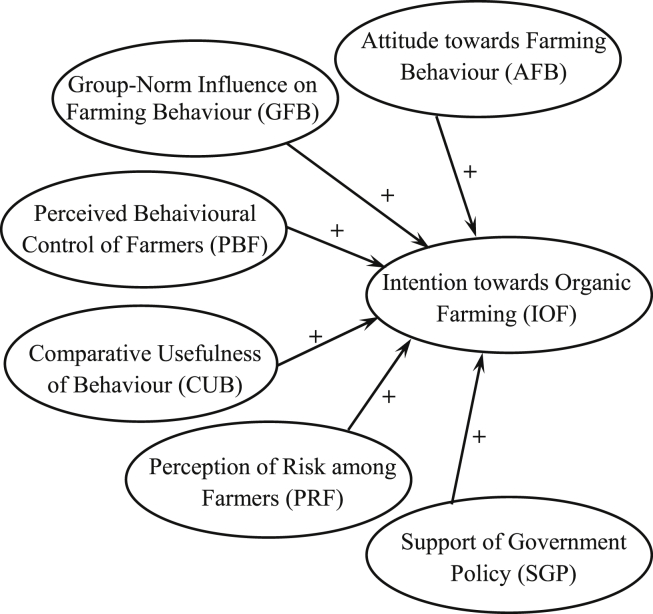
Conceptaul Framework: Model of farmers' intentions towards organic farming (Applied from Theory of planned behaviour, Ajzen, 1991).